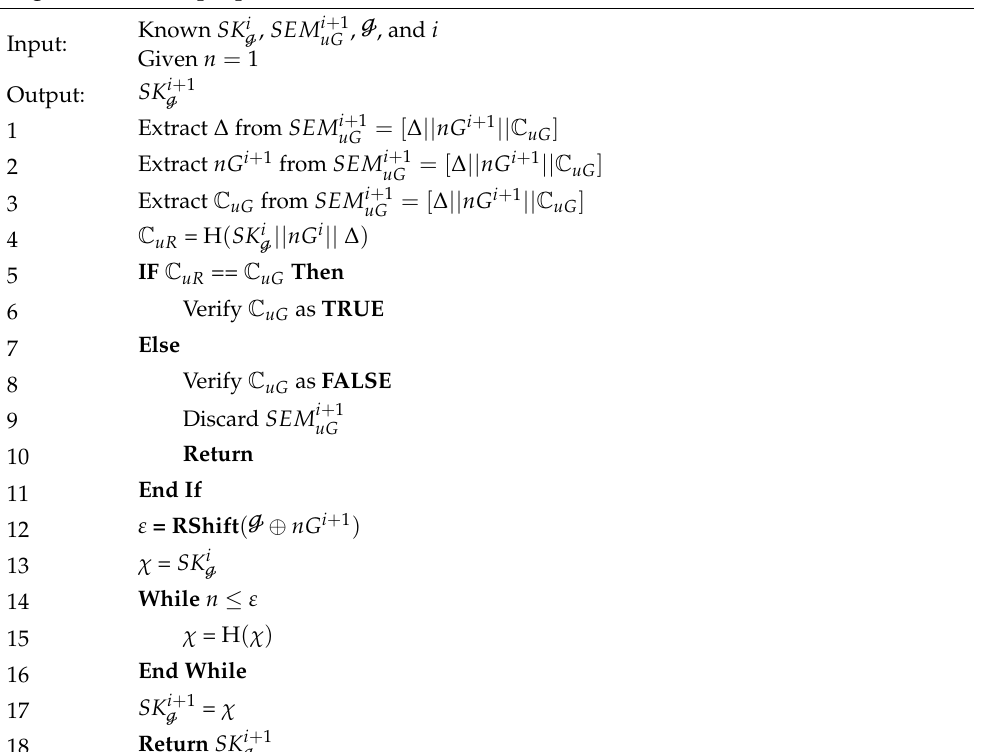
Algorithm 4: Group Operations in